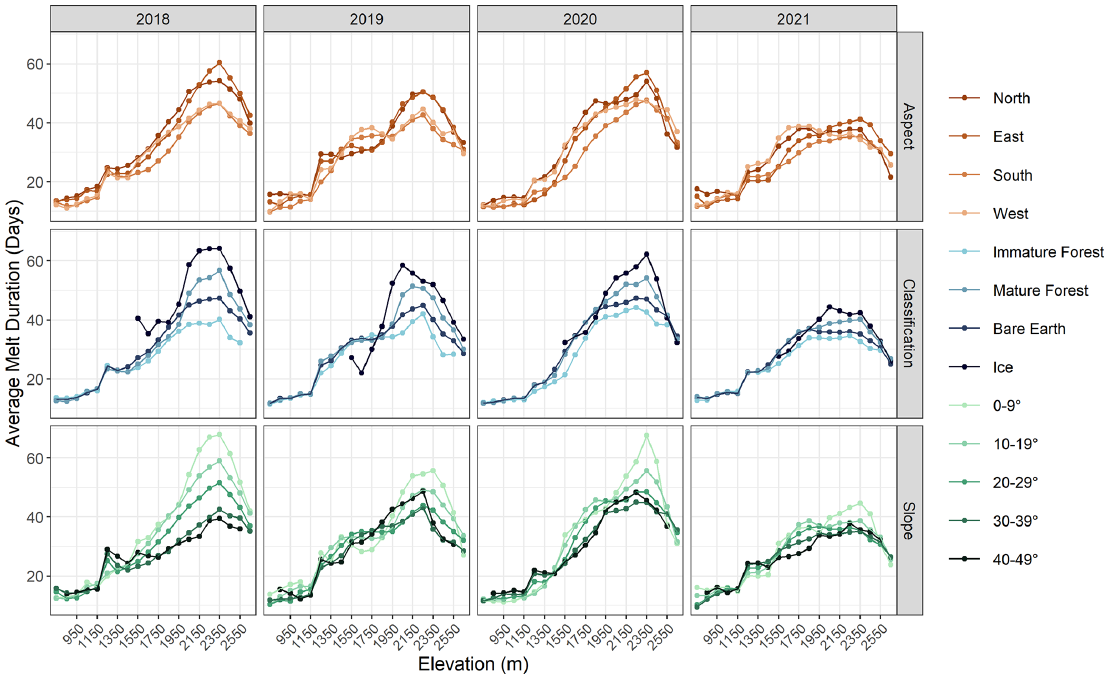
Figure 10. Average estimates of snowmelt duration by elevation, aspect, classification, and slope. Estimates of melt duration are derived from SAR-based estimates of melt onset and optical estimates of melt end. Averages are obtained from VV polarized SAR images.